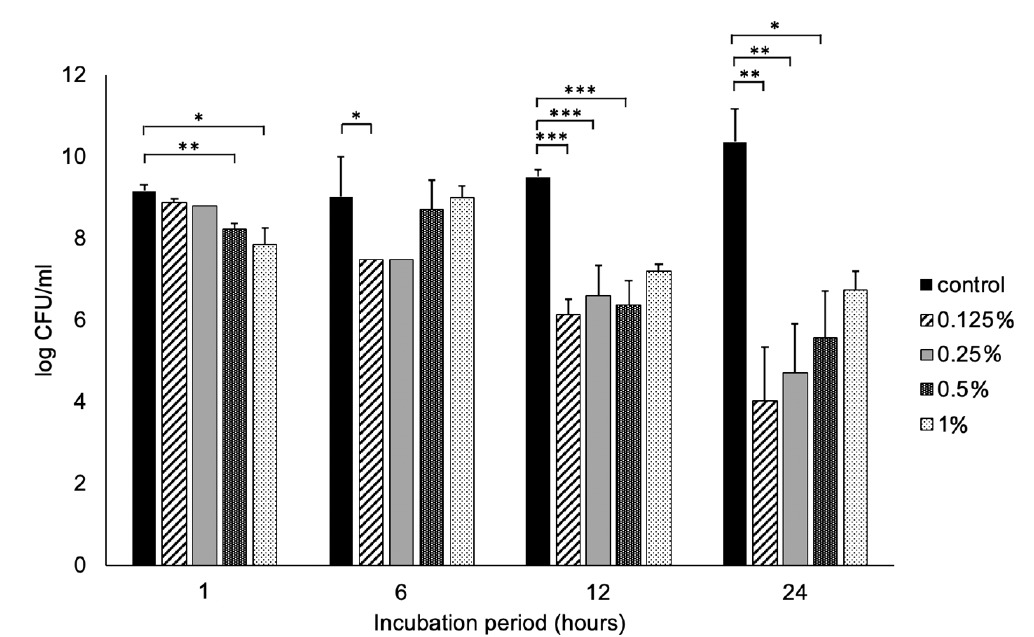
Figure 2. P. gingivalis bacterial viability measured as colony-forming units (CFU) on a log scale after 0.125%, 0.25%, 0.5%, and 1% ε -polylysine treatments for 0, 6, 12, and 24 h. All values depicted are the means of triplicate measurements. Statistical significance at * p < 0.05, ** p < 0.01, *** p < 0.001 by Mann-Whitney test.